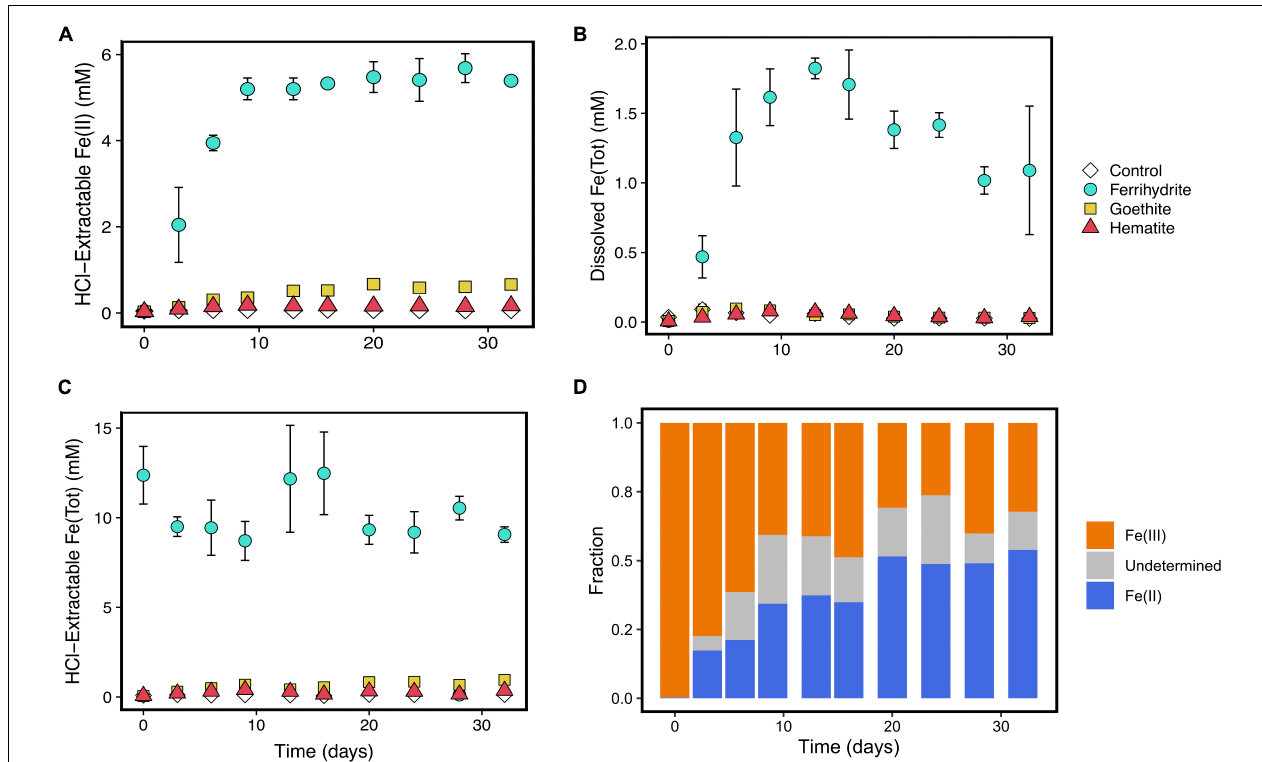
FIGURE 3 | Fe speciation over the course of incubation experiments including, hydrochloric acid-extractable Fe(II) (A) , aqueous Fe (B) , total HCl-extractable Fe (C) , and HCl-extractable solid speciation (D) . Error bars represent standard deviations of three replicates. Points without error bars have standard deviations smaller than the symbols. Error bars are left out of panel (D) for viewing clarity; values and error are shown in Supplementary Table 3 . Because aqueous Fe speciation was not determined, a portion of the solid HCl-extractable phase could not be determined because the total HCl-extractable Fe concentrations also include aqueous